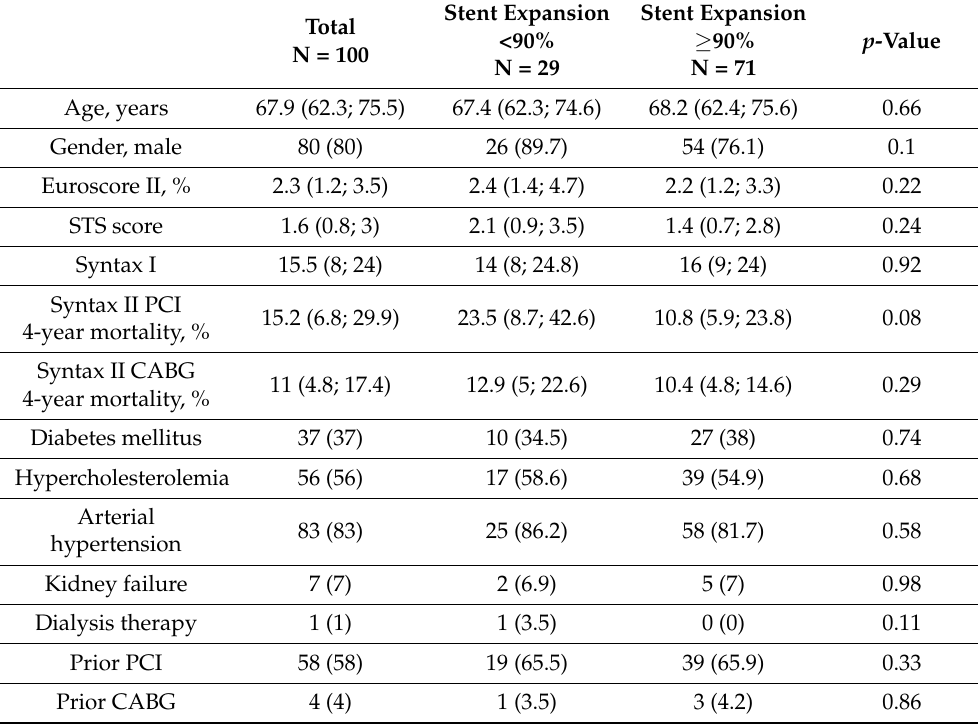
Table 1. General characteristics and concomitant